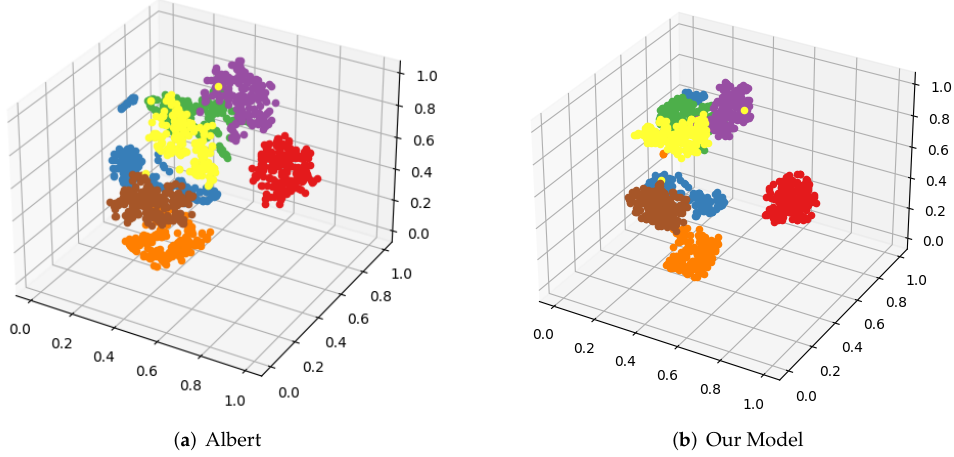
Figure 4. Visualization of the classification results on the PaperNet_CV dataset. (Red: CV_attention; Yellow: CV_classification; Green: CV_segmentation; Brown: CV_retrieval; Purple: CV_recognition; Blue: CV_detection; Orange: